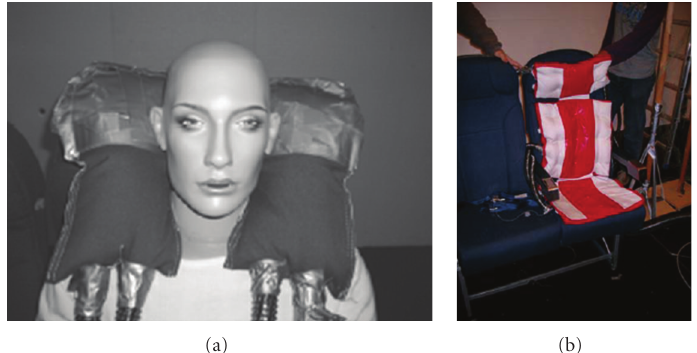
Figure 4: PVs integrated to aircraft seats to study cross infection. (a) PV integrated to the neck-support pillow, (b) PV integrated to the seat